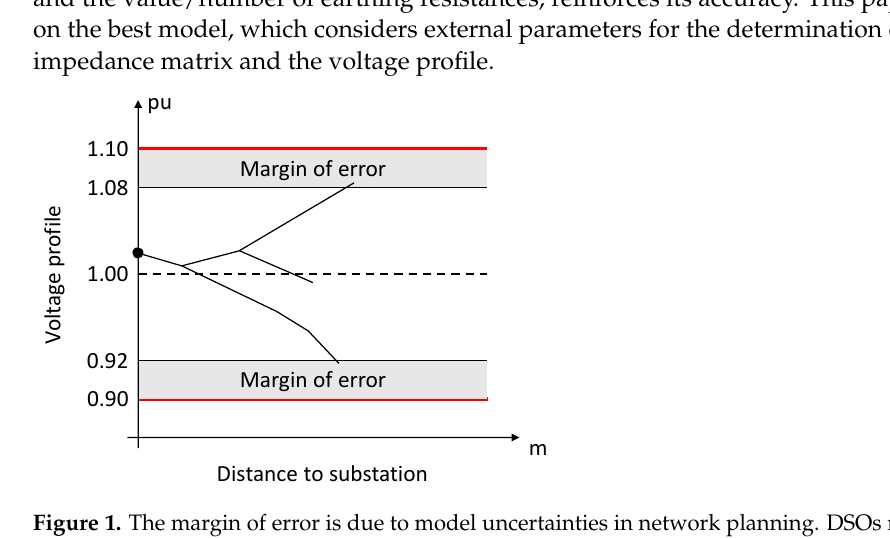
Figure 1. The margin of error is due to model uncertainties in network planning. DSOs require these margins to avoid voltage problems.